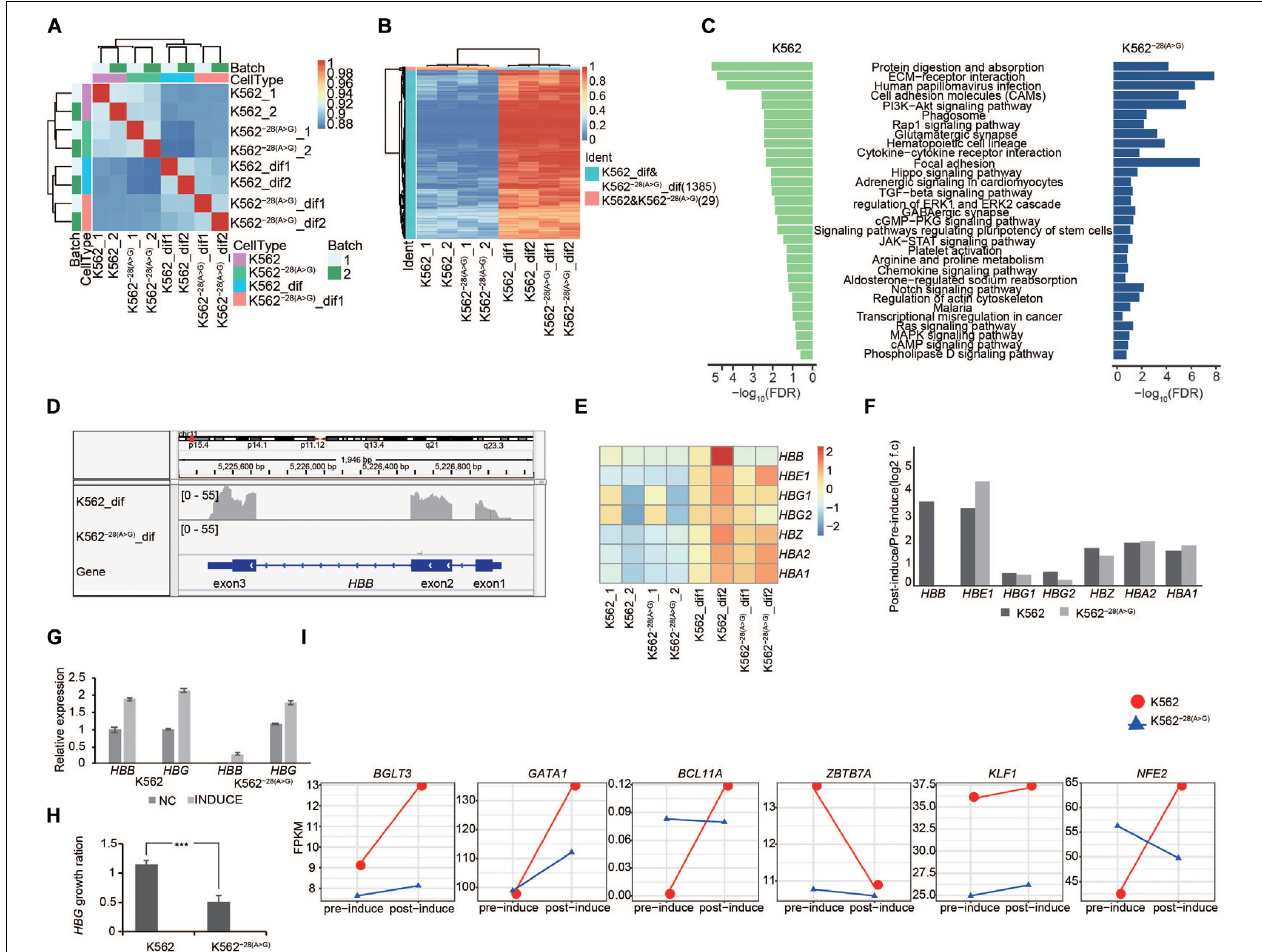
FIGURE 3 | Transcriptome analysis of coregulated genes in K562 and K562 − 28 ( A > G ) cell lines after erythroid differentiation. (A) Pairwise Pearson correlations are represented in matrix between K562 and K562 − 28 ( A > G ) . The differentiated groups are clustered together. (B) Heat map shows the coregulated genes in K562 and K562 − 28 ( A > G ) after erythroid differentiation when compared to those before differentiation. (C) KEGG signaling pathways enriched in differentiated K562 and K562 − 28 ( A > G ) when compared to their corresponding cell lines before differentiation. (D) The IGV shows the HBB gene expression in K562 and K562 − 28 ( A > G ) cell lines. (E) Expression of globin genes determined by RNA-seq in the K562 and K562 − 28 ( A > G ) cell lines pre- and post- induction. (F) Change trends, post-induction FPKM/pre-induction FPKM (log2 f.c) of globin genes determined by RNA-seq in the K562 and K562 − 28 ( A > G ) cell lines pre- and post- induction. (G) Expression of globin HBB and HBG determined by qRT-PCR in the K562 and K562 − 28 ( A > G ) cell lines pre- and post- induction. (H) Change trends of globin HBB and HBG determined by qRT-PCR in the K562 and K562 − 28 ( A > G ) cell lines pre- and post- induction. T -test was used to process statistical analysis. *** means p < 0.001. (I) Expression of key transcription factors related to erythroid differentiation. Y axis represents expression level